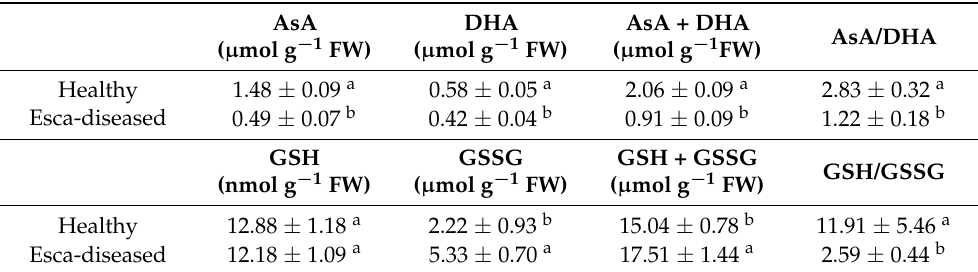
Table 6. Effect of esca on the AsA, DHA, and ascorbate pool (AsA + DHA) contents, and the AsA/DHA ratio, the GSH, GSSG, and glutathione pool (GSH + GSSG) contents, and the GSH/GSSG ratio, in grapes of Vitis vinifera cv.